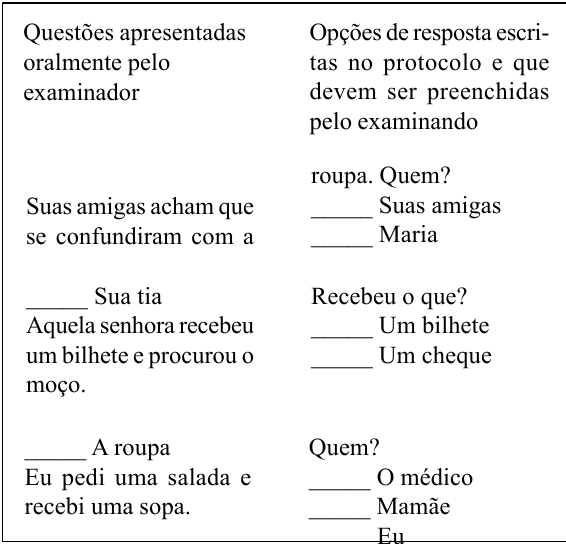
Figura 5 . Exemplo dos itens de coordenação na modalidade aritmética da BAMT-UFMG Nota. Nessa tarefa, o participante deve responder a questão e, ao mesmo tempo, memorizar o último número do cálculo dito pelo experimentador.